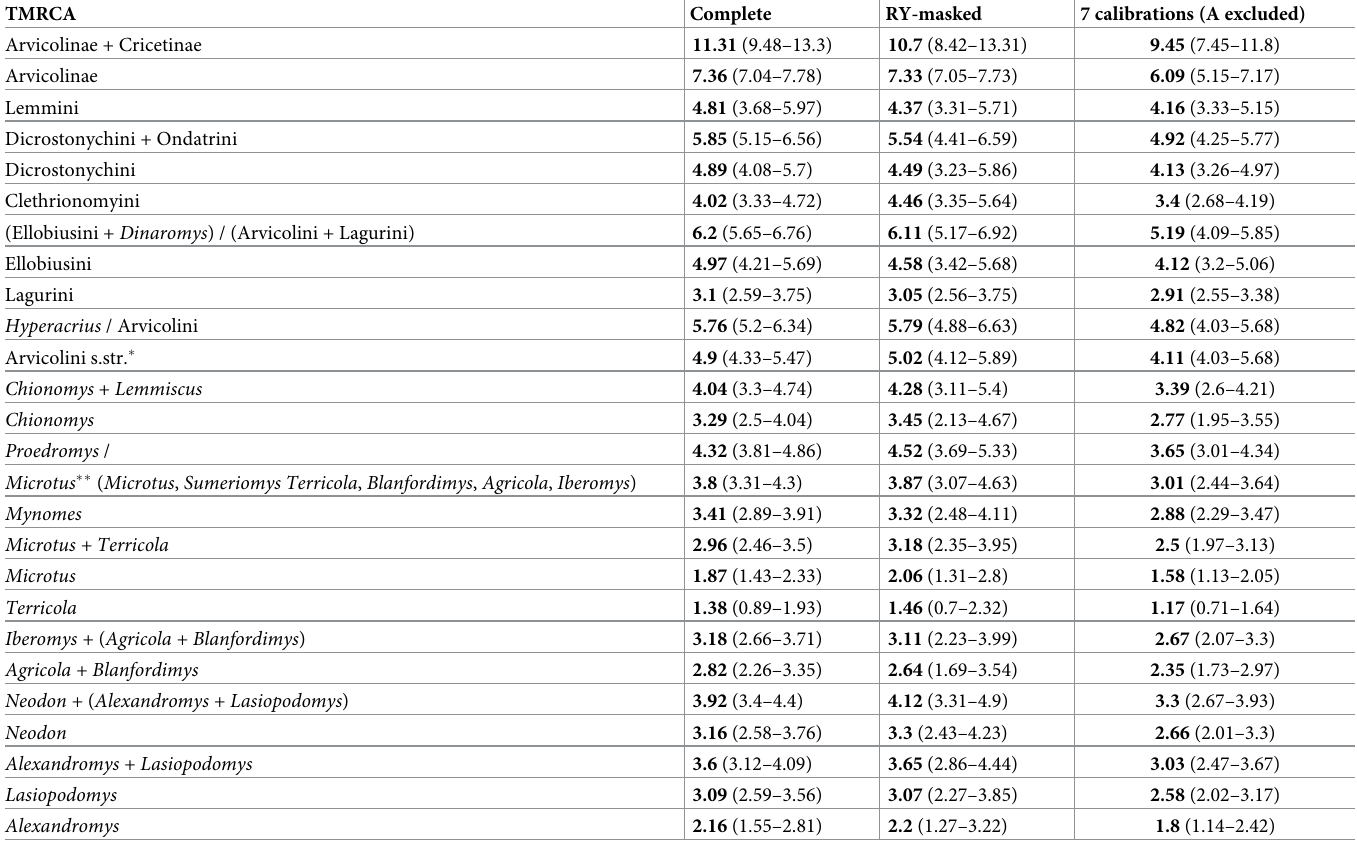
Table 1. Divergence time estimates for the major lineages within the subfamily Arvicolinae.